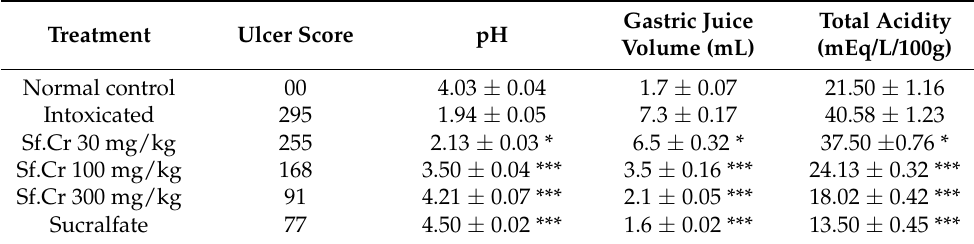
Table 1. Effect of Sf.Cr and sucralfate on ulcer score, pH, gastric volume, and total acidity in ethanol- induced gastric